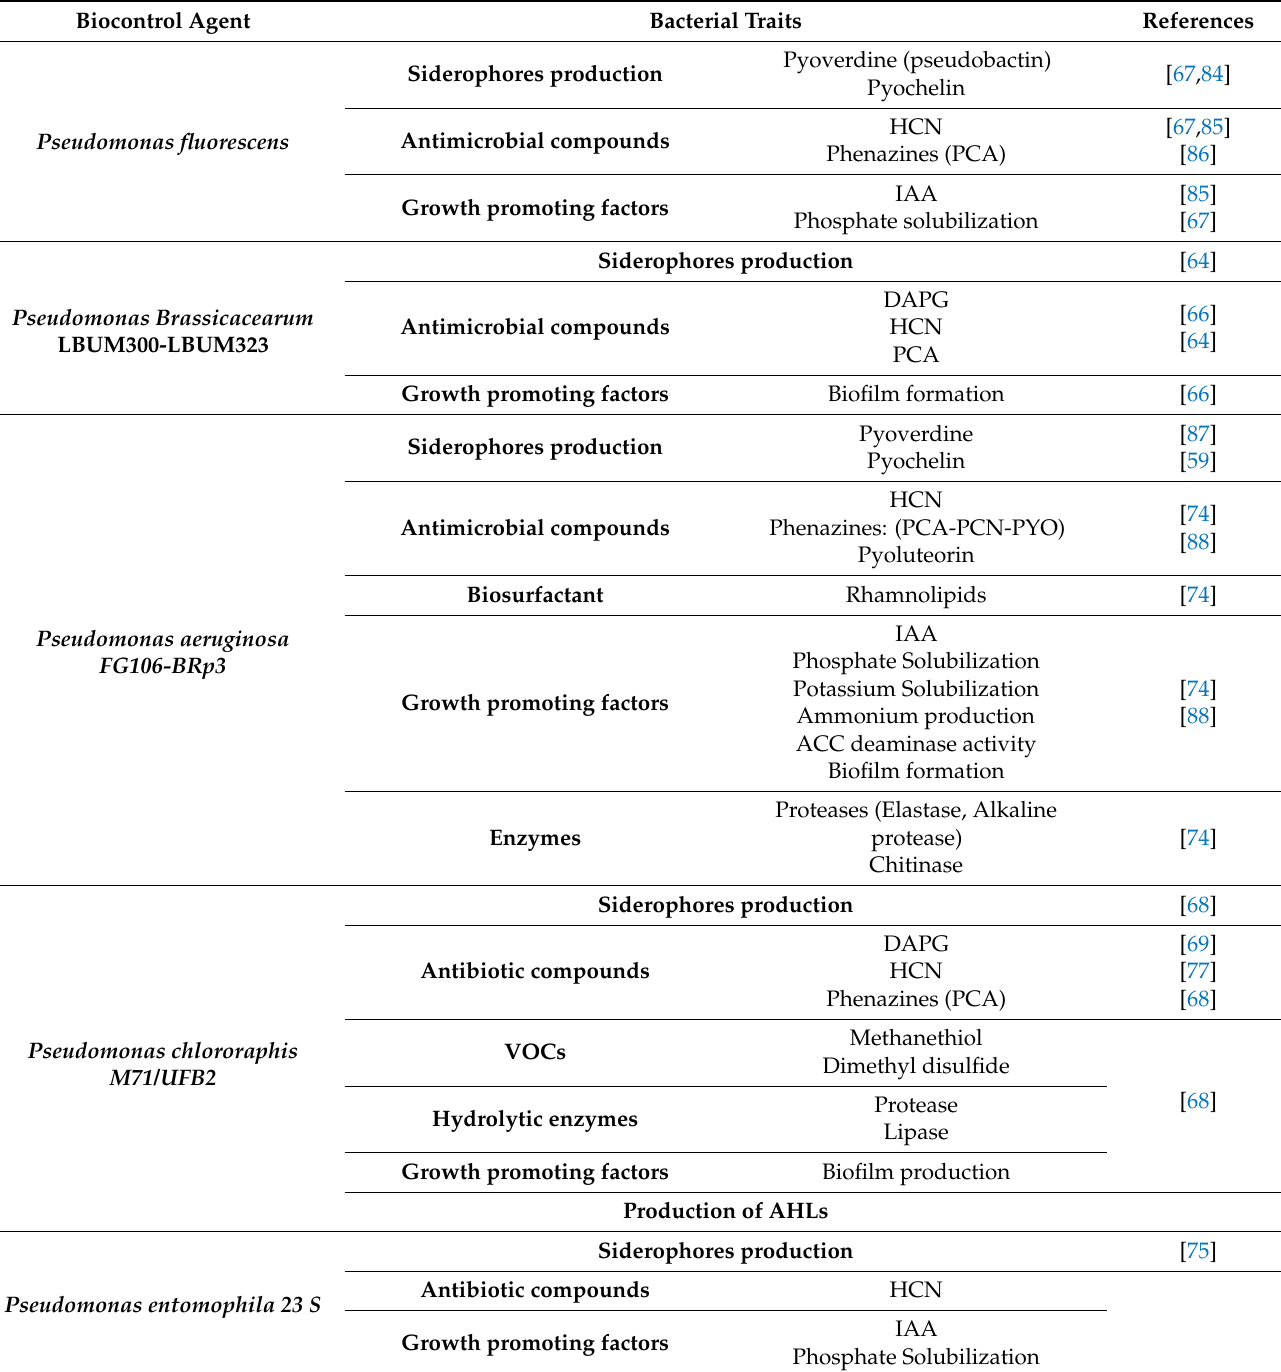
Table 1. Overview of the modes of action of Pseudomonas strains to enhance plant growth and to control C. michiganensis